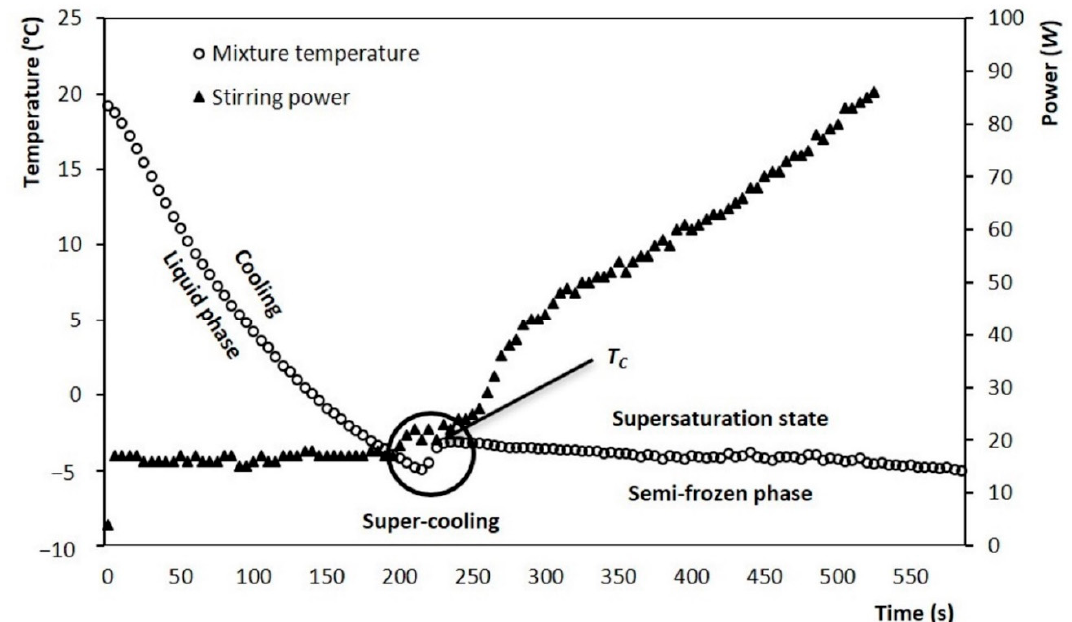
Figure 2. Evolution of the mixture temperature ( ▲ ) during crystallization in the SSHE and evolution of the power consumed by stirring motor ( ○ ), test performed at 200 rpm (3.33 s − 1 ).